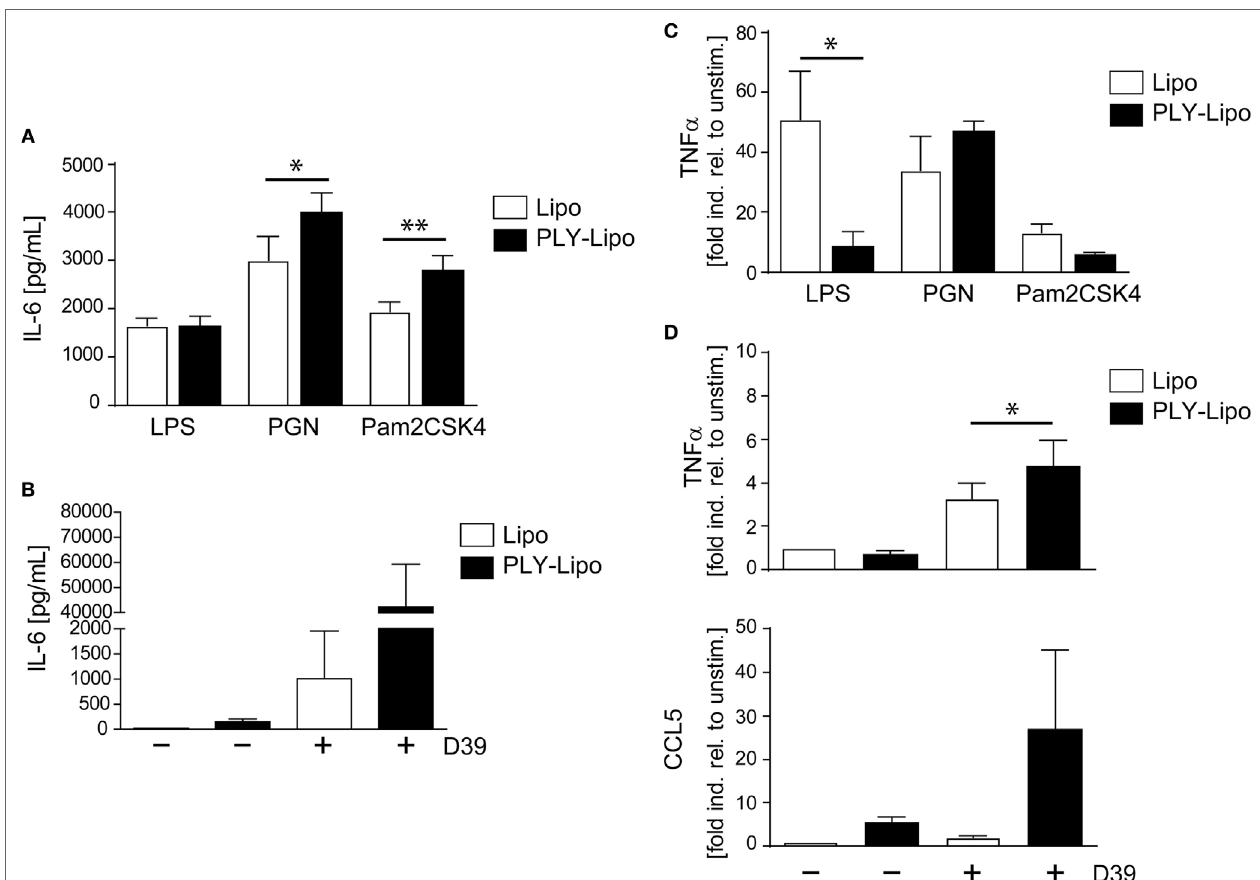
FigUre 4 | Pneumolysin (PLY)-liposome induced macrophages respond differentially to PRR ligands. Day 7 M-CSF induced human macrophages were stimulated with PLY-liposomes (PLY-Lipo) or liposomes only (Lipo) for 48 h. After stimulation, cell media was removed, macrophages were washed once, and re-stimulated with a TLR4 ligand (LPS), a TLR2 ligand (Pam2CSK4), a NLR ligand (PGN), or supernatant from Streptococcus pneumonia strain D39 ( D39 ). (a,B) PLY-liposome induced macrophages show an enhanced response to Gram-positive PRR/TLR ligands. Re-stimulation of PLY-Lipo induced macrophages was performed with 100 ng/ml LPS, 1 µg/ml Pam2CSK4, 1 µg/ml PGN, or supernatants from Streptococcus pneumonia D39 for 6 h. IL-6 production was analyzed by collecting supernatants at 6 h and performing Bio-Plex measurements (mean ± SD, n = 6; * p < 0.05, ** p < 0.005, paired t -test, two-tailed). (c,D) TNF α upregulation in PLY-liposome